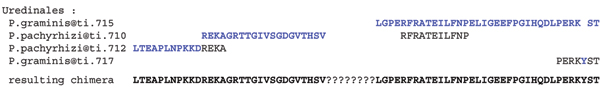
Example of chimera assembly. Sequence fragments are combined from longest to shortest, the length being computed according to the number of characters: selected parts are displayed in blue; the chimerical sequence is the result of the concatenation of each part of the different sequences